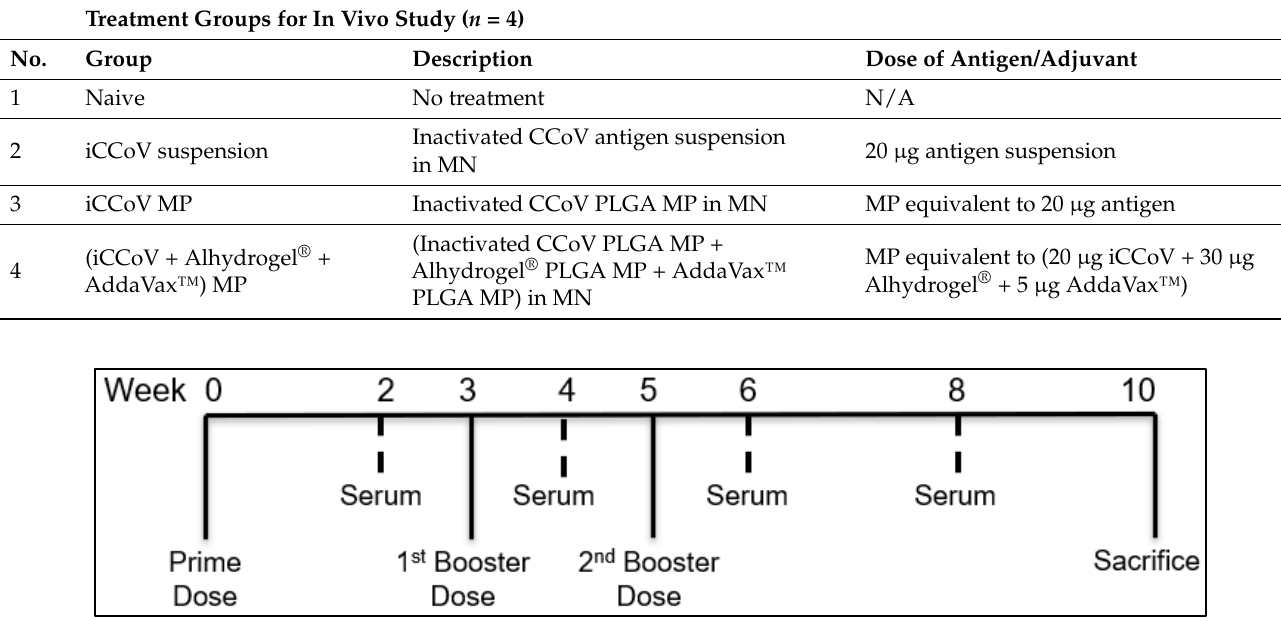
Figure 2. Timeline of in vivo immunization study in mice. The mice were vaccinated in three doses at W0, W3, and W5. The sera of the mice were collected and assessed for their antibody levels at W2, W4, W6, and W8. The mice were then sacrificed at W10. Table 1. Description of treatment groups involved in the in vivo study.